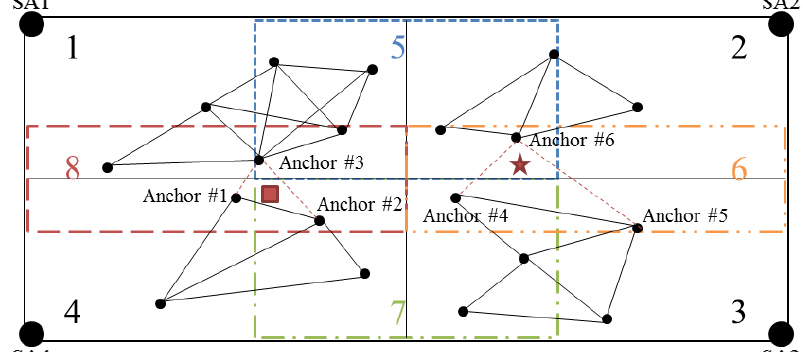
Figure 4. Localization of nodes  and  after segmentation of field to four non-overlapping and four overlapping sub-